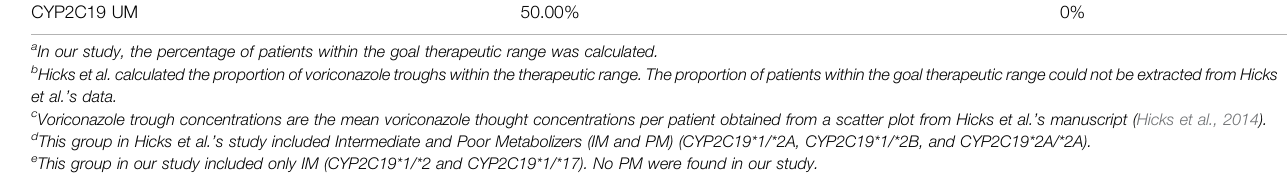
TABLE5| Percentageofpatients a /troughs b withingoaltherapeuticrangesubgroupedbyphenotypeandage.Comparisonofourresults(A)withthosefoundinHicksetal. ’ s study with standard care and (B) and simulation with extrapolated doses (C).